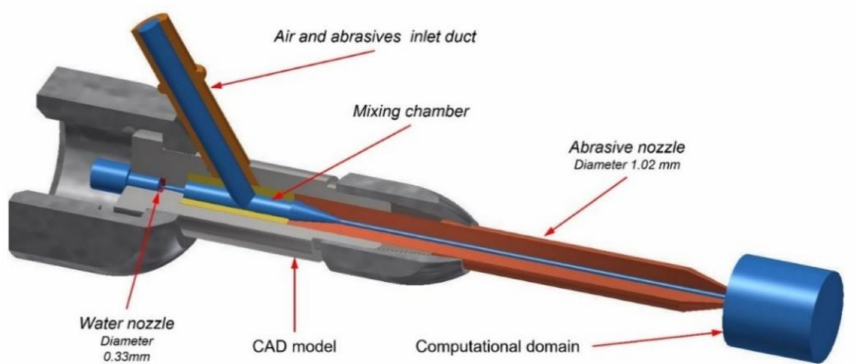
Figure 1. CAD model and computational domain of the abrasive